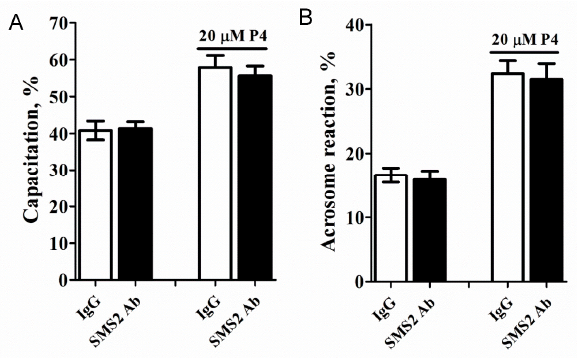
Figure 5. The e ff ect of inhibition of the SMS2 activity on the capacitation and acrosome reaction. ( A ) The e ff ect of inhibition of the SMS2 activity on capacitation. ( B ) The e ff ect of inhibition of the SMS2 activity on the acrosome reaction.